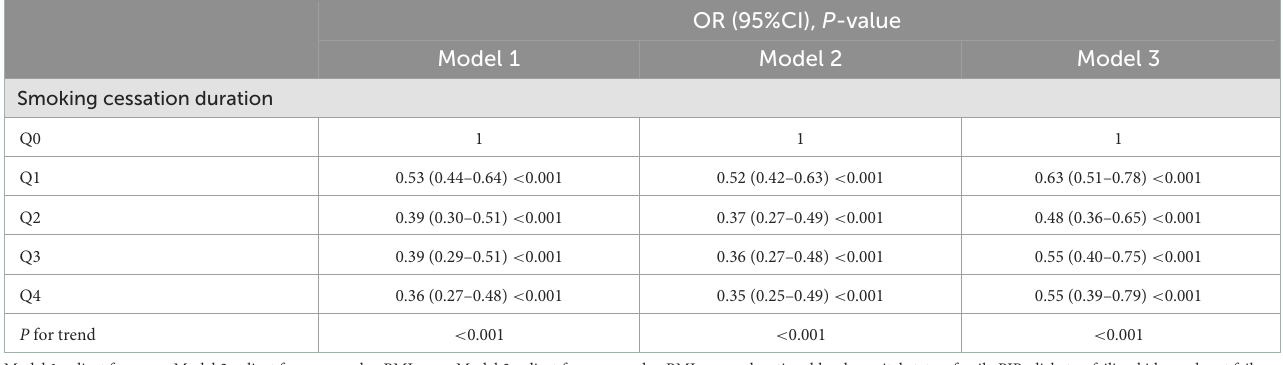
TABLE 9 Smoking cessation duration as categorical variables to analyze the relationship between smoking cessation and depression in adults ( n = 13,651) in NHANES (2005–2018).